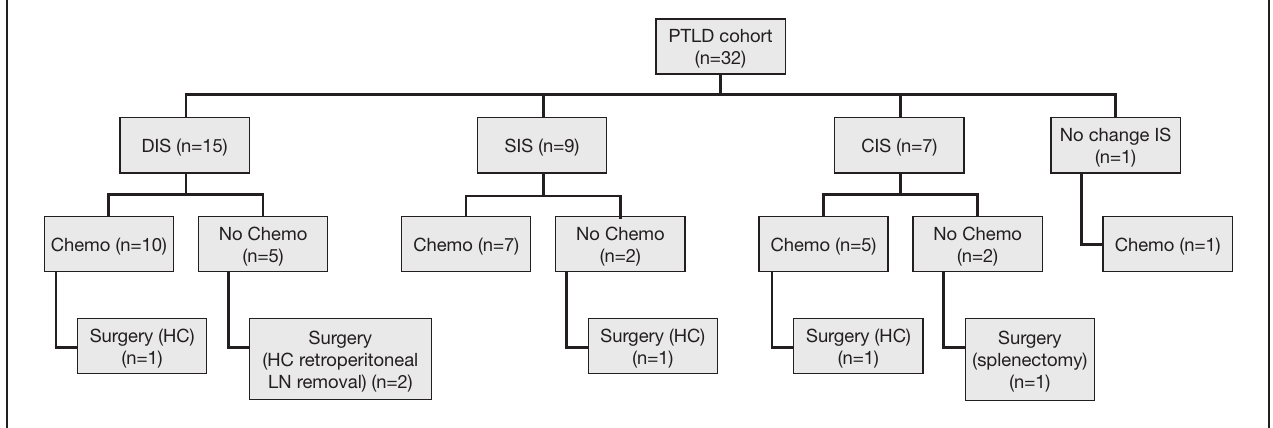
Figure 1) Algorithm of various interventions used in the cohort of post-transplant lymphoproliferative disorder (PTLD) patients. Chemo Chemotherapy; CIS Changing immunosuppression to sirolimus; DIS Decrease in immunosuppression; HC Hemicolectomy; IS Immunosuppression; LN Lymph node; SIS